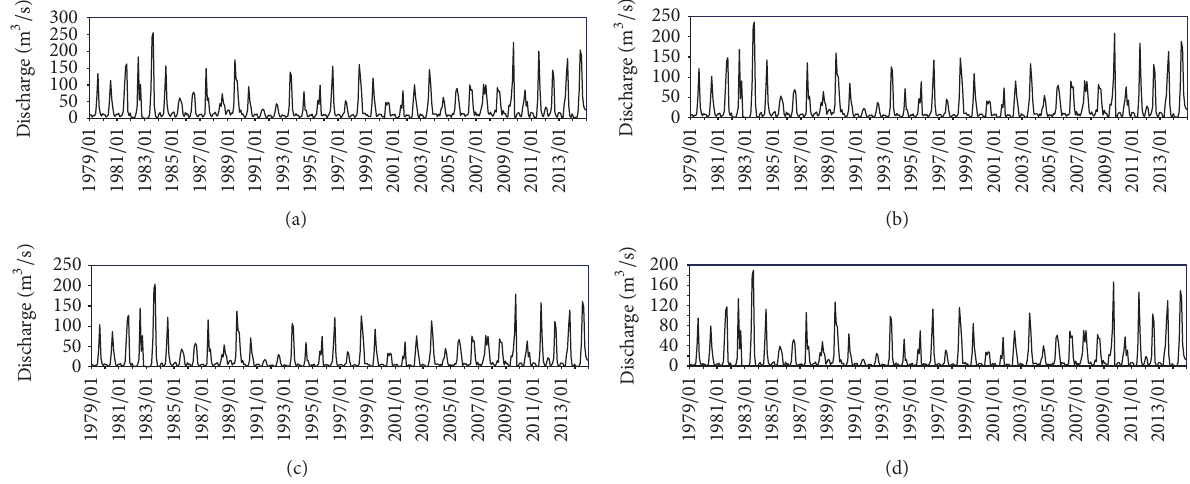
Figure 5: 1979–2014 estimated discharge at the Caotanzhuang (a), the S213 Bridge (b), the G312 Bridge, (c) and the Tielu Bridge